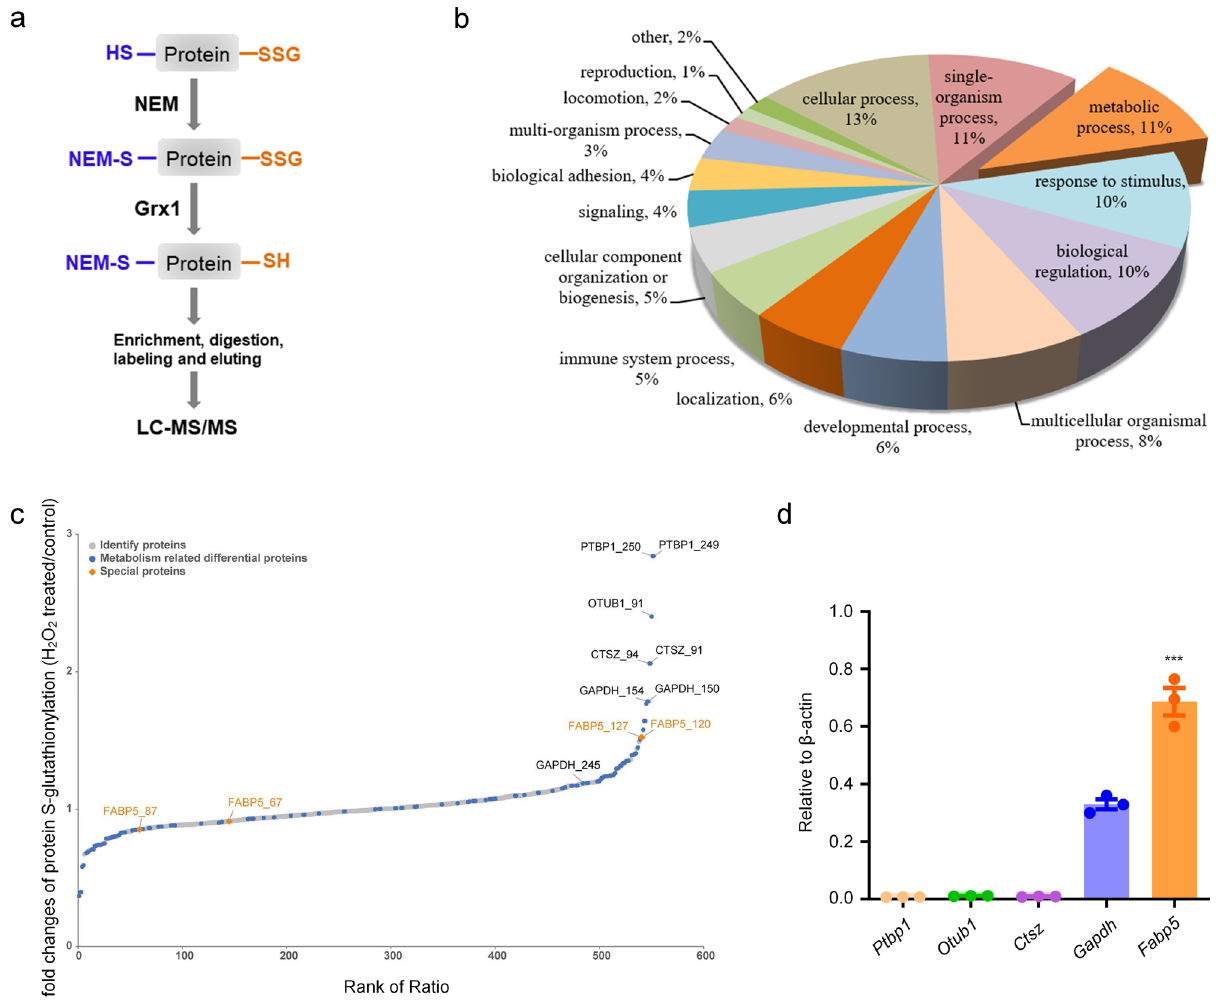
Fig. 3 Alterations of protein S-glutathionylation modi fi cation in macrophages under oxidative conditions. a Schematic of the enrichment and quantitative analysis for SSG-modi fi ed Cys-peptides. b Enrichment of protein SSG and LC – MS/MS in BMDMs exposed to H 2 O 2 (200 μ M) for 0, 15 min. Gene ontology annotations for biological process of proteins with signi fi cant S-glutathionylation alterations found to be increased or decreased in any stage by >1.2-fold compared to control. The slice for metabolic process is slightly displaced from the rest of the pie chart. c Alterations in S-glutathionylation sites under exposure to H 2 O 2 [shown as fold changes of protein S-glutathionylation (H 2 O 2 treated/control). Gray, identi fi ed protein sites; blue, metabolism- related differential proteins; orange, FABP5]. d mRNA levels of Ptbp1 , Otub1 , Ctsz , Gapdh , and Fabp5 in BMDMs as evaluated by qPCR, n = 3 biologically independent samples over 3 independent experiments, data are shown as mean ± SEM and analyzed with a 95% con fi dence interval, P < 0.0001, one-way ANOVA is followed by Tukey ’ s post-hoc test. Source data are provided as a Source Data fi